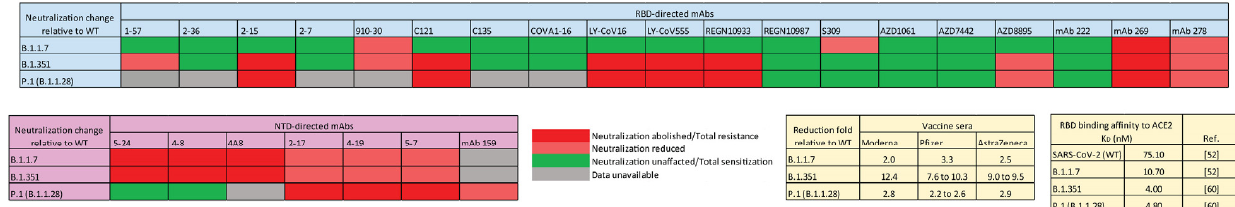
Figure 7. Neutralisation by RBD- and NTD-directed mAbs and vaccine anti-sera against B.1.1.7, B.1.351 and P.1 (B.1.1.28), relative to the wild-type virus. Neutralisation results, compiled from different studies which used several neutralisation assays: focus reduction neutralisation assay, where the reduction in the number of the infected foci is compared to a no antibody negative control well, was used in the neutralisation studies of B.1.1.7 [52] and P.1 [60], whereas end-point dilution neutralisation assay, where percentage neutralisation at a given sample dilution or mAb concentration is measured, was used in the neutralisation studies of B.1.1.7/B.1.351 [56] and P.1 [77]. The B.1.351 and P.1 variants potentially reduced the neutralisation of both RBD- and NTD-directed mAbs, while the B.1.1.7 variant showed reductions particularly in the neutralisation of the NTD-directed mAbs compared to the wild-type SARS-CoV-2. Vaccine sera used in these studies were obtained at 14 and 28 days following the second dose of the AstraZeneca AZD1222 vaccine [52,60] and 4-14 days [60] or 7-17 days [52,56] following the second dose of the Pfizer BNT162b2 vaccine. For the Moderna mRNA-1273 vaccine, the serum was collected 15 days following the second dose of the vaccine [56,77]. Although there were marked reductions in the neutralisation of vaccine sera, they remain robust, protecting these variants by the currently deployed vaccines. Bottom right: the table summarises the binding affinity ( K D ) of RBD of different SARS-CoV-2 variants to ACE2 using bio-layer interferometry